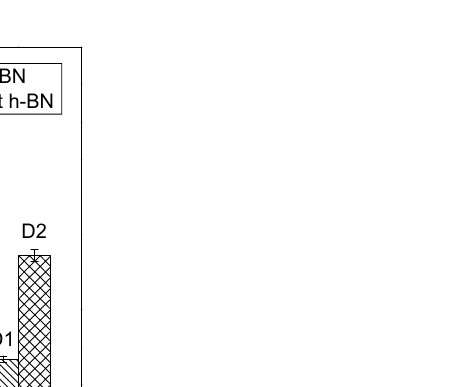
Figure 2. Surface morphology of the coatings. Subfigures ( a ),( c ),( e ) and ( g ) are the surface morphologies of the coatings without h-BN particles in the tenth, twentieth, thirtieth and fortieth minutes, respectively; Subfigures ( b ),( d ),( f ) and ( h ) are the surface morphologies of the coatings with h-BN particles in the tenth, twentieth, thirtieth and fortieth minutes, respectively.